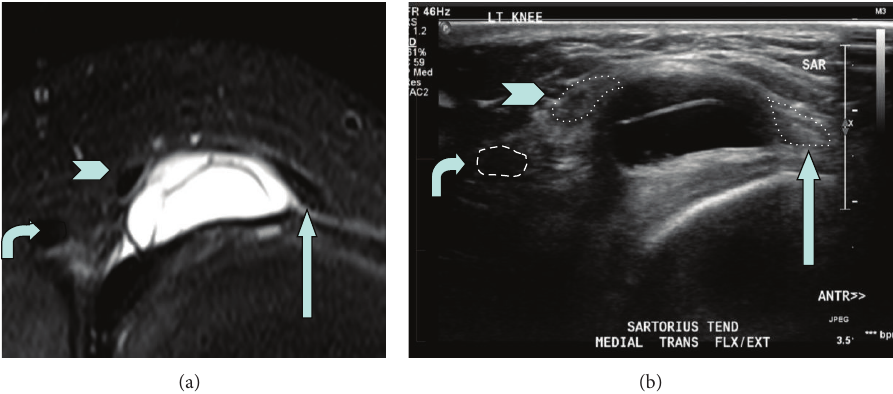
Figure 3: Comparison of (a) fat-saturated proton density MRI and (b) ultrasound left knee. Straight arrow: sartorius tendon; chevron: gracilis tendon; curved arrow: semitendinosus, with sartorius and gracilis “splayed apart” by parameniscal